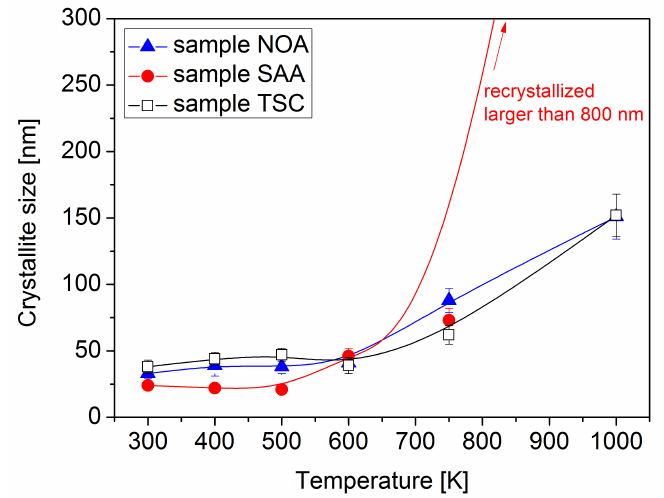
Figure 2. The crystallite size obtained by XLPA versus the heat treatment temperature. The curves are only for guidance and do not represent any fitting